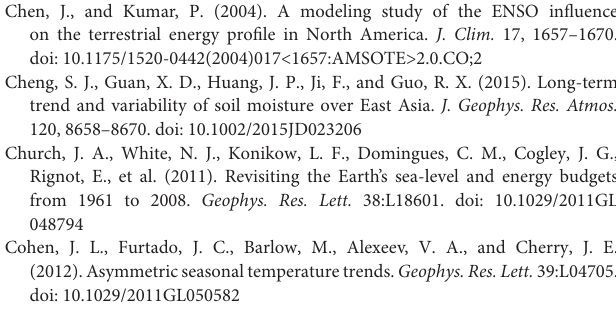
methods on the complex and non-linear soil system. As the can account for all of the temporal changes in soil